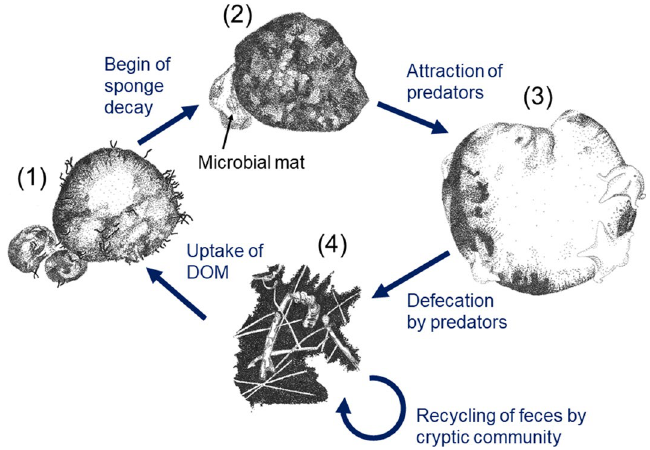
Figure 6. Conceptual model of the sponge loop likely present at the seamounts of the Langseth Ridge. The individual components of the sponge loop are the following: (1) Putatively healthy Tetractinellida sponges, (2) microbial mat covering a sponge, (3) asteroids predating upon the microbial mat covering a Tetractinellida sponge/ directly upon the sponge, (4) mat of polychaete tubes intermixed with sponge spicules hosting a cryptic microbial and faunal community. Illustrations by Tanja